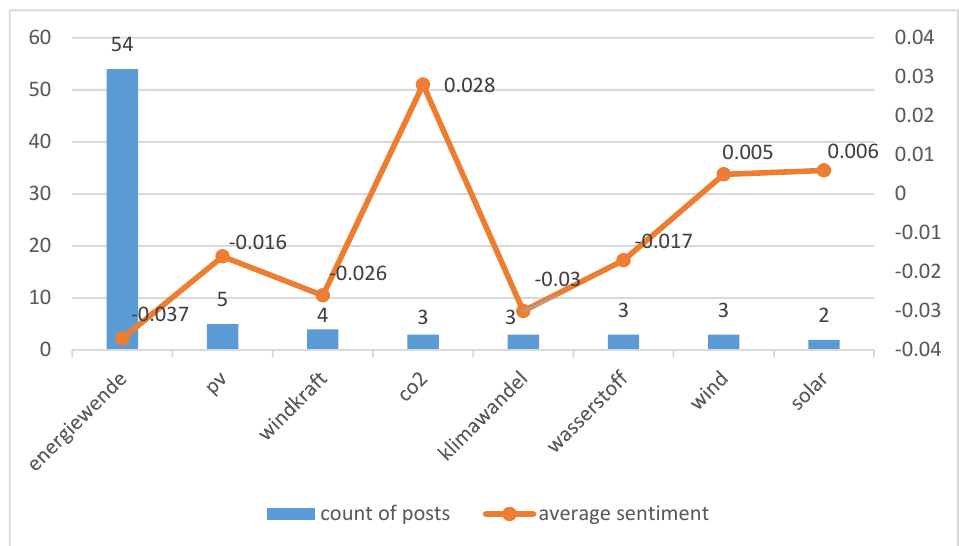
Figure 10. Analysis of the German group named “Energiewende”.